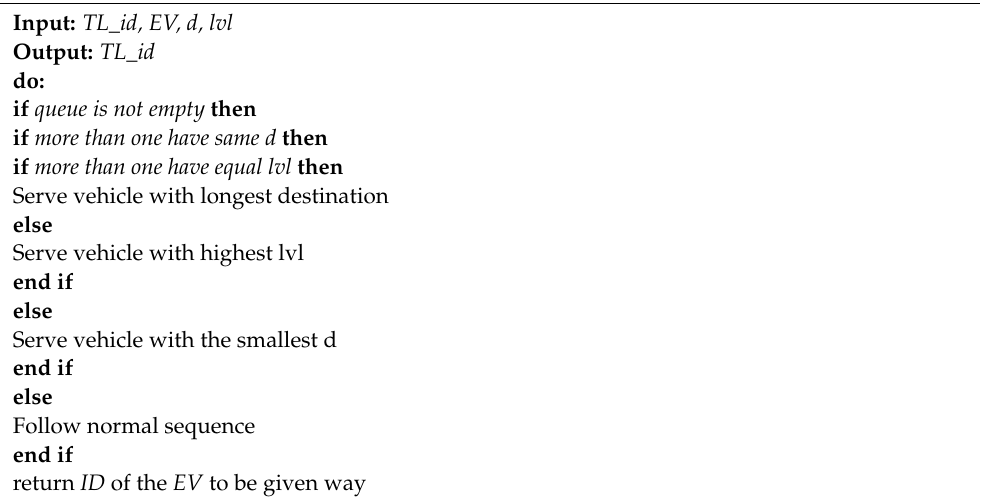
Algorithm 2: J2H algorithm for customizing traffic